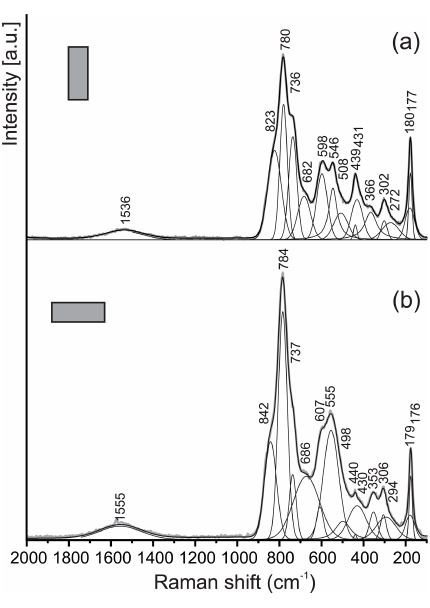
Figure 5. Raman spectra of kahlenbergite for two orientations of crystals. Laser beam is polarized